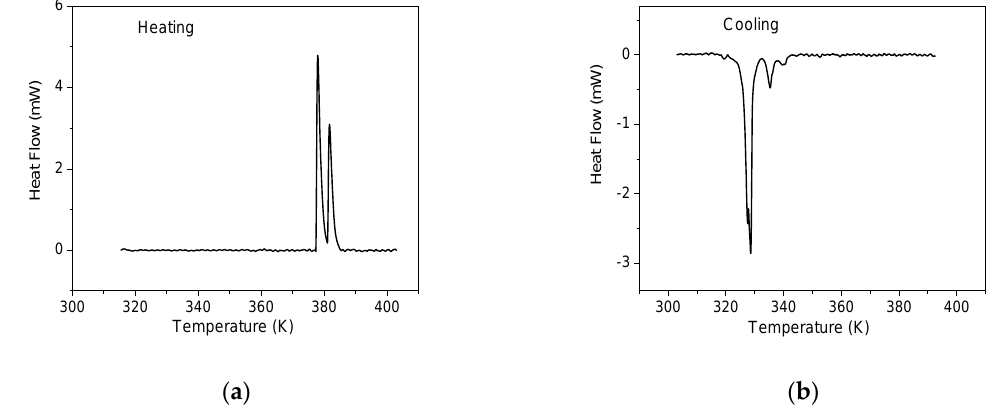
Figure 2. DSC runs for heating ( a ) and cooling ( b ) of the stress-induced martensite stabilized (SIM-aged) Ni 51 Fe 18 Ga 27 Co 4 single crystals.